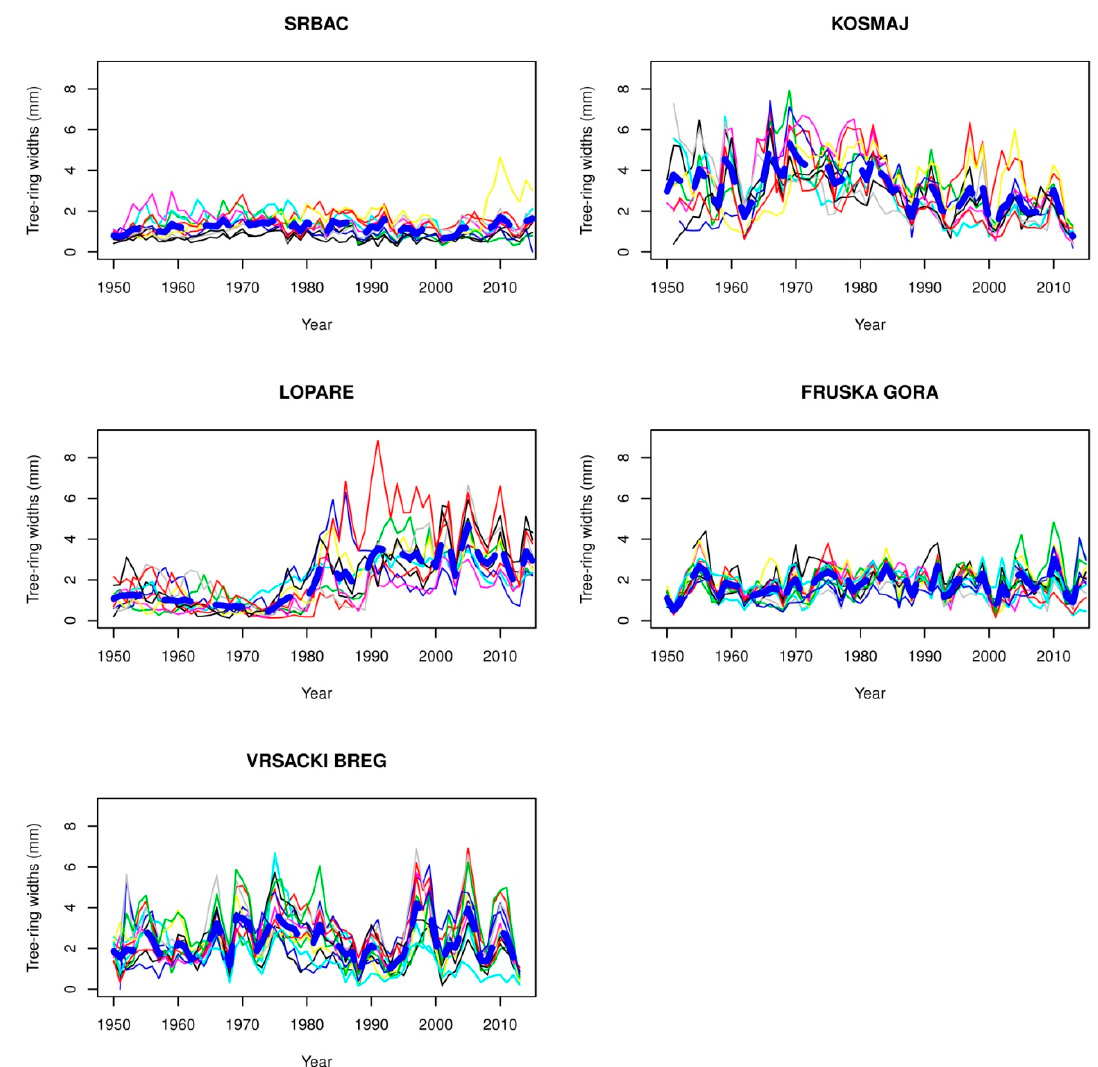
Figure 2. Chronology of beech trees at the lower limit of their vertical distribution.